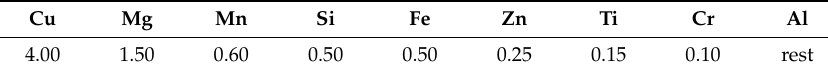
Table 2. Composition of aluminum–copper alloy (Weight